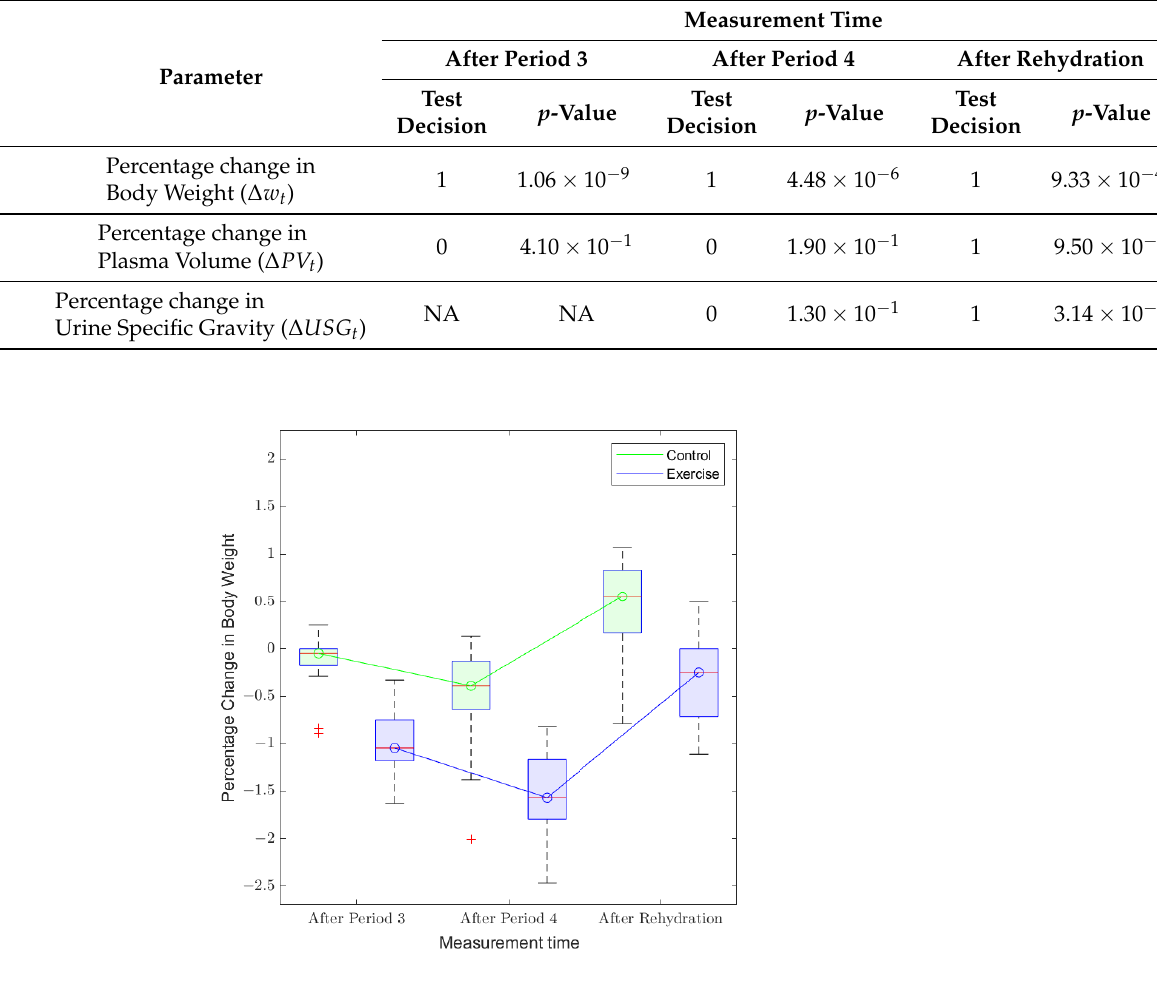
Figure 7. Summary of variations in percentage changes in body weight over different time intervals for the participants. Table 5. Correlation coefficients corresponding to different predictor variables during all measure- ment times. ∆ Fx t denotes the percentage change in the mean of S21 magnitudes corresponding to frequency band x at measurement time t , as compared to baseline. ∆ Fx t is calculated as shown in Equation